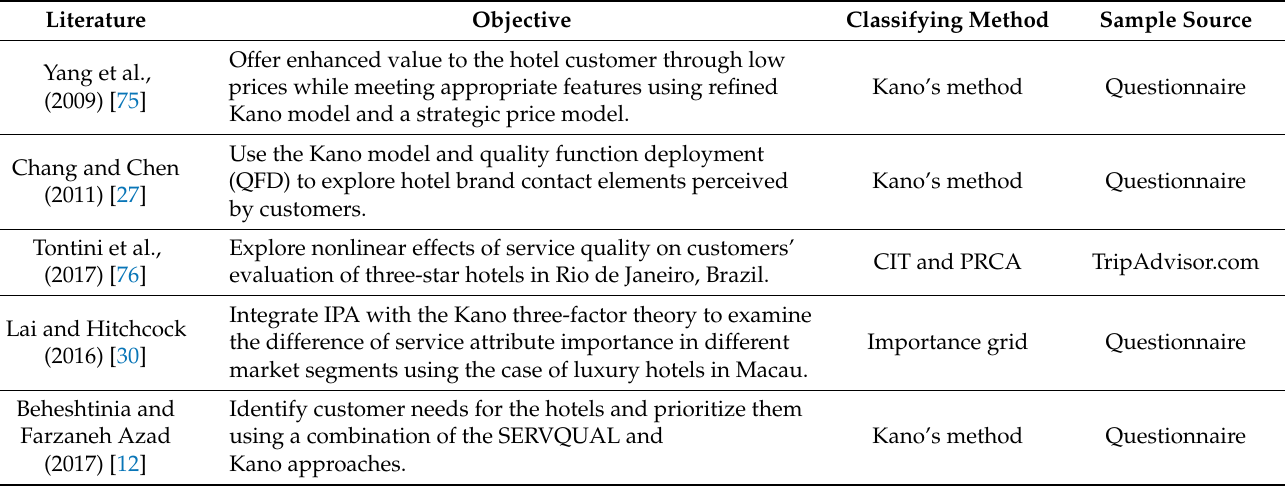
Table 1. Related studies of Kano model in hospitality research.